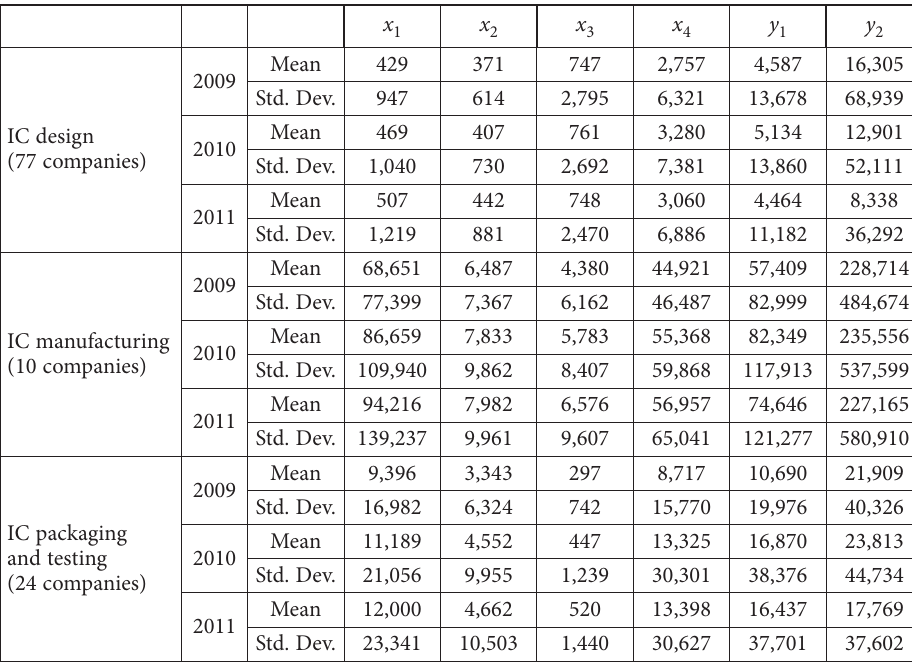
Table 2. Descriptive statistics of the inputs and outputs from 2009 to 2011 x 1 x 2